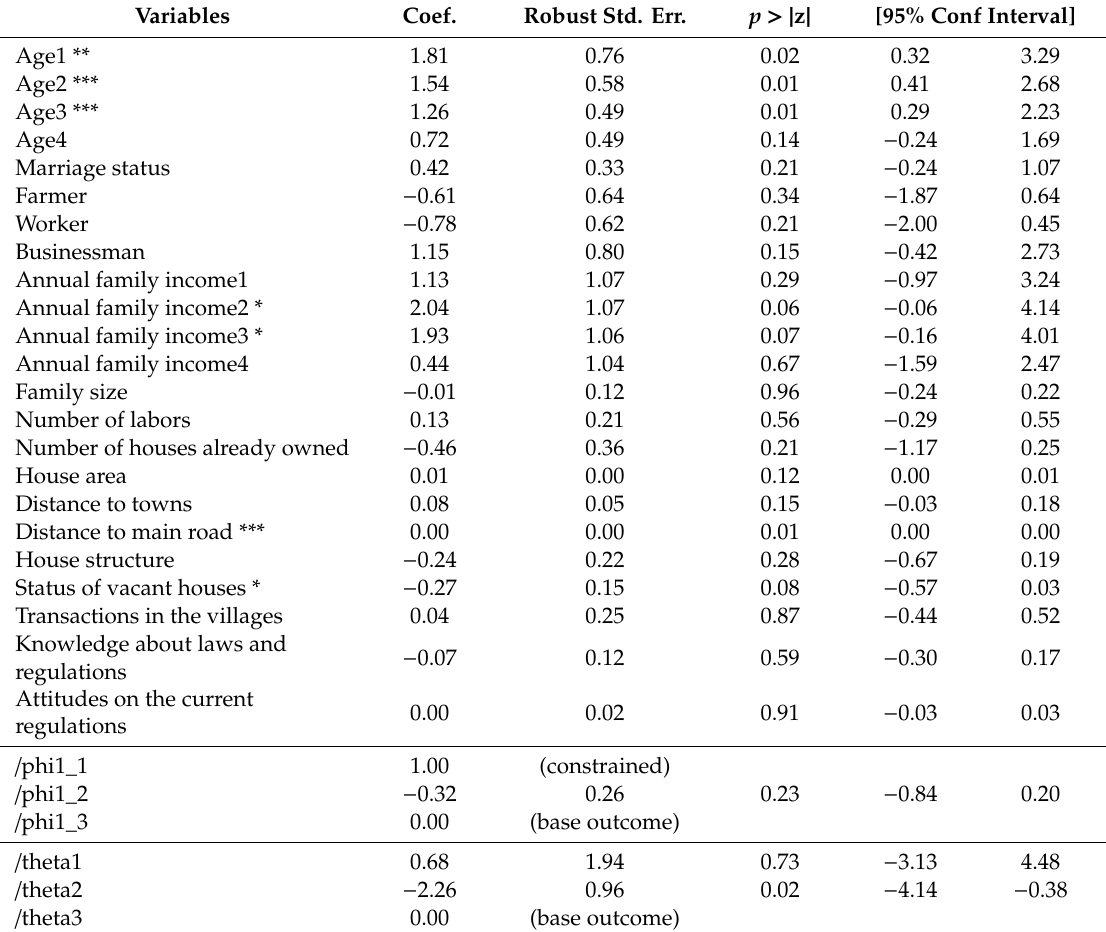
Table 8. The estimation results of house owners’ willingness to sell their properties.